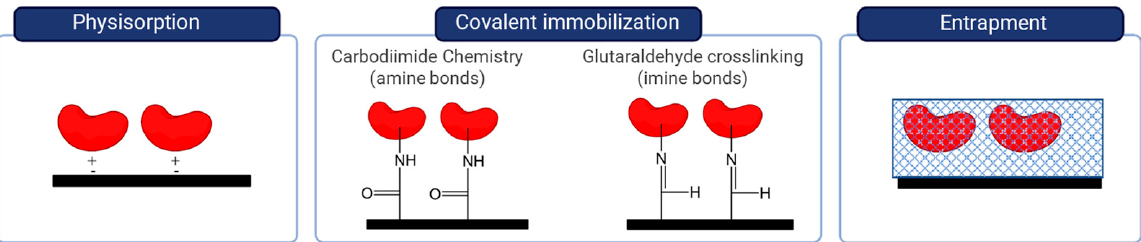
Figure 6. Schematic representation of the most common methods used to immobilize bioreceptors in the development of sweat biosensors. Physisorption relies on intermolecular interactions between the bioreceptor (red) and the electrode (black). Most common methods for covalent immobilization rely on the formation of amide or imine bonds. Bioreceptors can be also entrapped by encapsulation within a hydrogel (light blue).